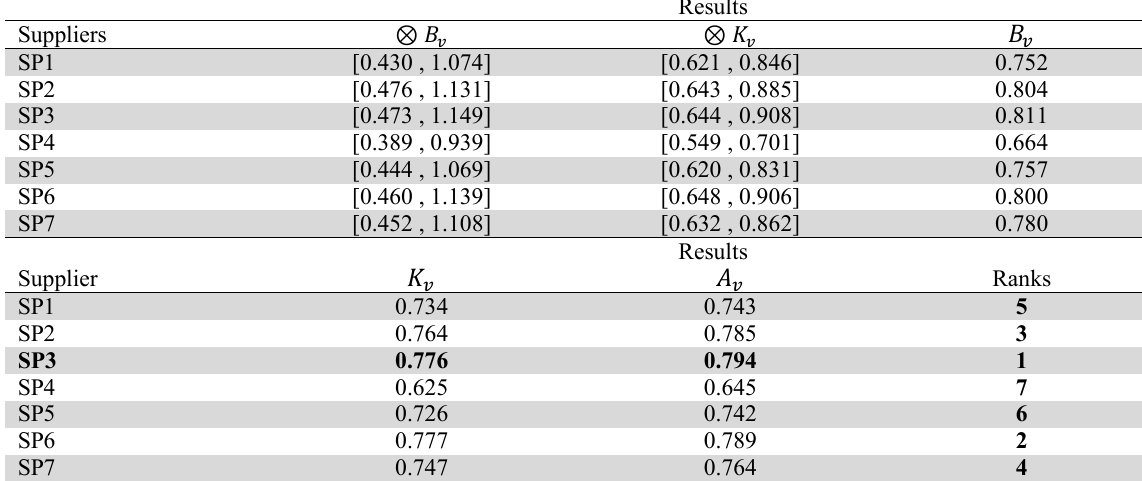
Final results of the constructed Grey